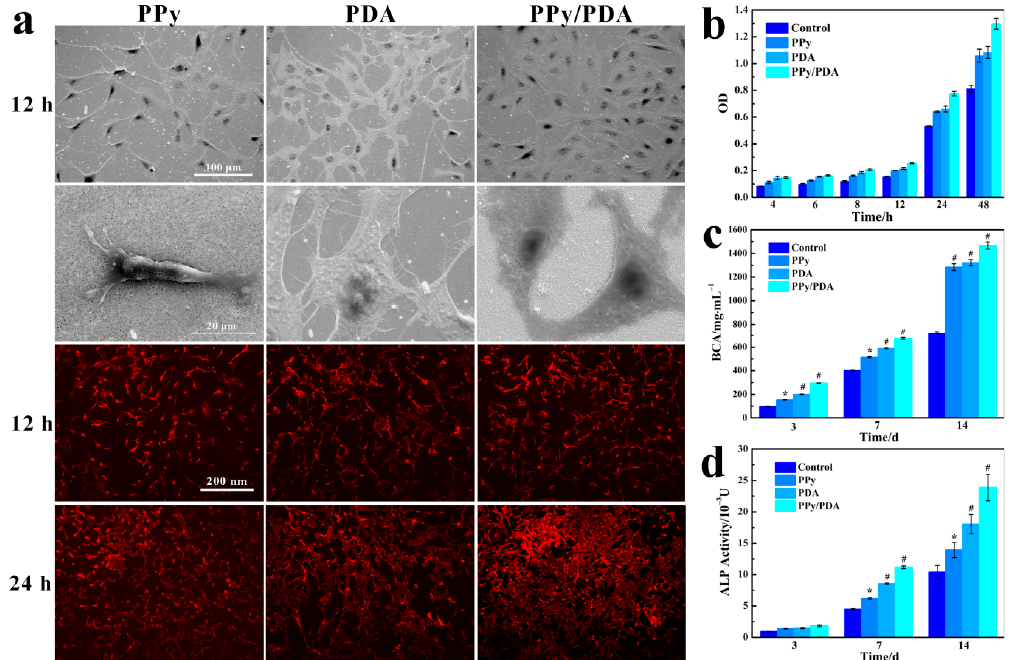
Figure 5. ( a ) SEM and fluorescence images of MC3T3-E1 cells on PPy NWs, PDA and PPy/PDA NWs cultured for 12 h and 24 h. ( b ) Proliferation of MC3T3-E1 cells on different coatings. ( c ) The protein content of MC3T3-E1 cells cultured on different coatings. ( d ) The ALP activity of MC3T3-E1 cells cultured on different coatings. * p < 0.05, and # p < 0.01.